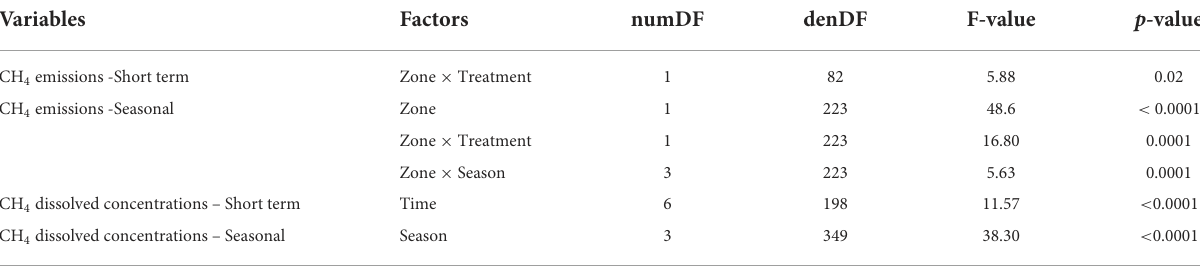
TABLE 1 Significant effect of single factors and their interaction ( p ≤ 0.05) on dissolved CH 4 concentrations, emissions, and oxidative fraction ( F -stat) after linear mixed effect model analysis. Variables Factors